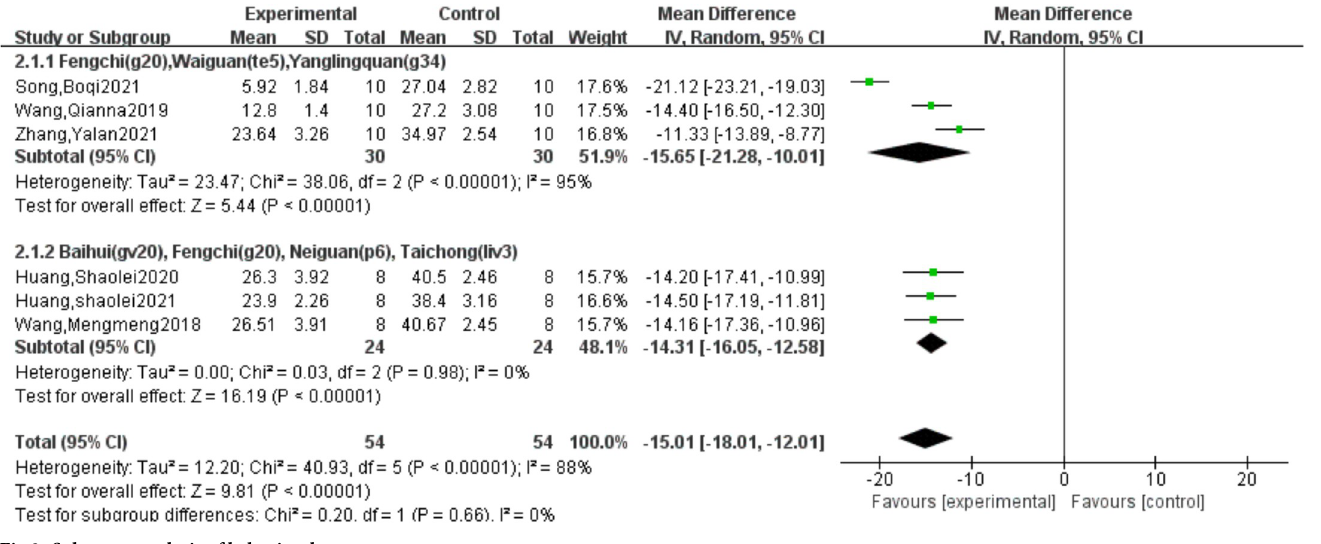
Fig 2. Subgroup analysis of behavioral